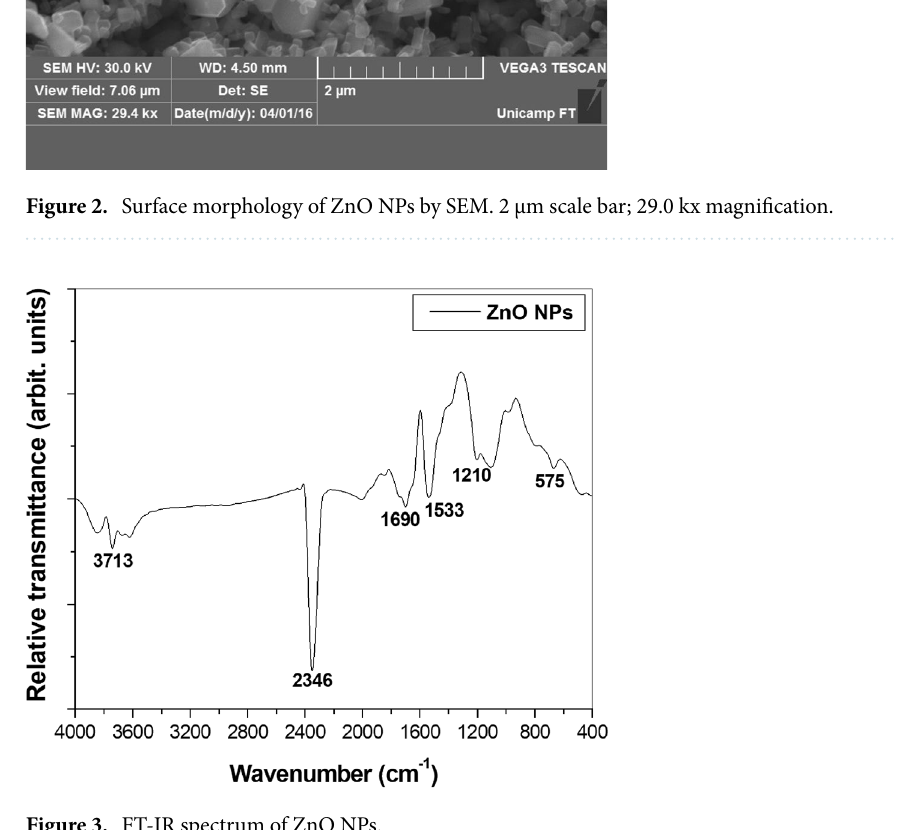
Figure 3. FT-IR spectrum of ZnO